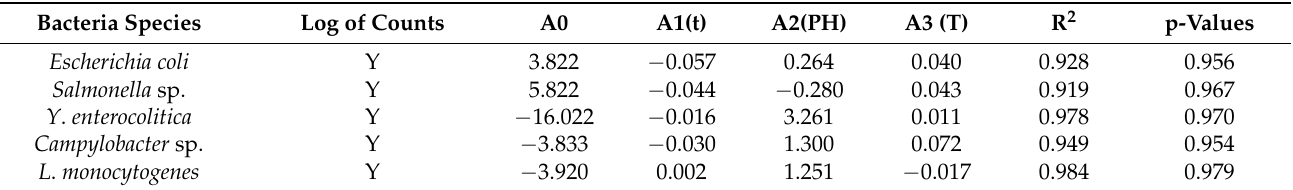
Table 1. Multiple linear regression models of log bacterial counts with number of days, pH, and average daily temperature as predictors.